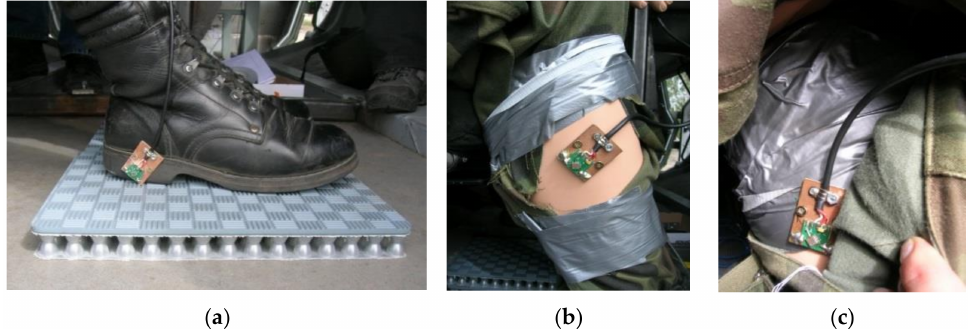
Figure 7. Measurement points on the dummy with attached MEMS accelerometers: ( a ) feet, ( b ) lower leg, ( c ) pelvis.